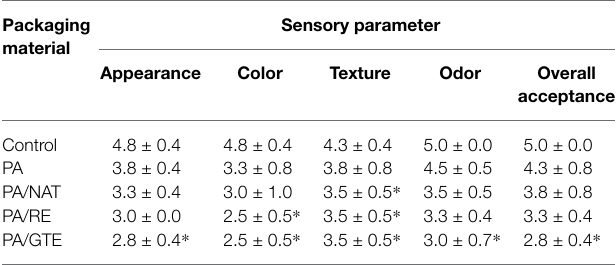
TABLE 4 | Sensory evaluation of chicken breast fillets samples packed in aluminum foil (control), PA, PA/NAT, PA/RE, and PA/GTE and stored for 7 days at 7 ° C. Packaging material